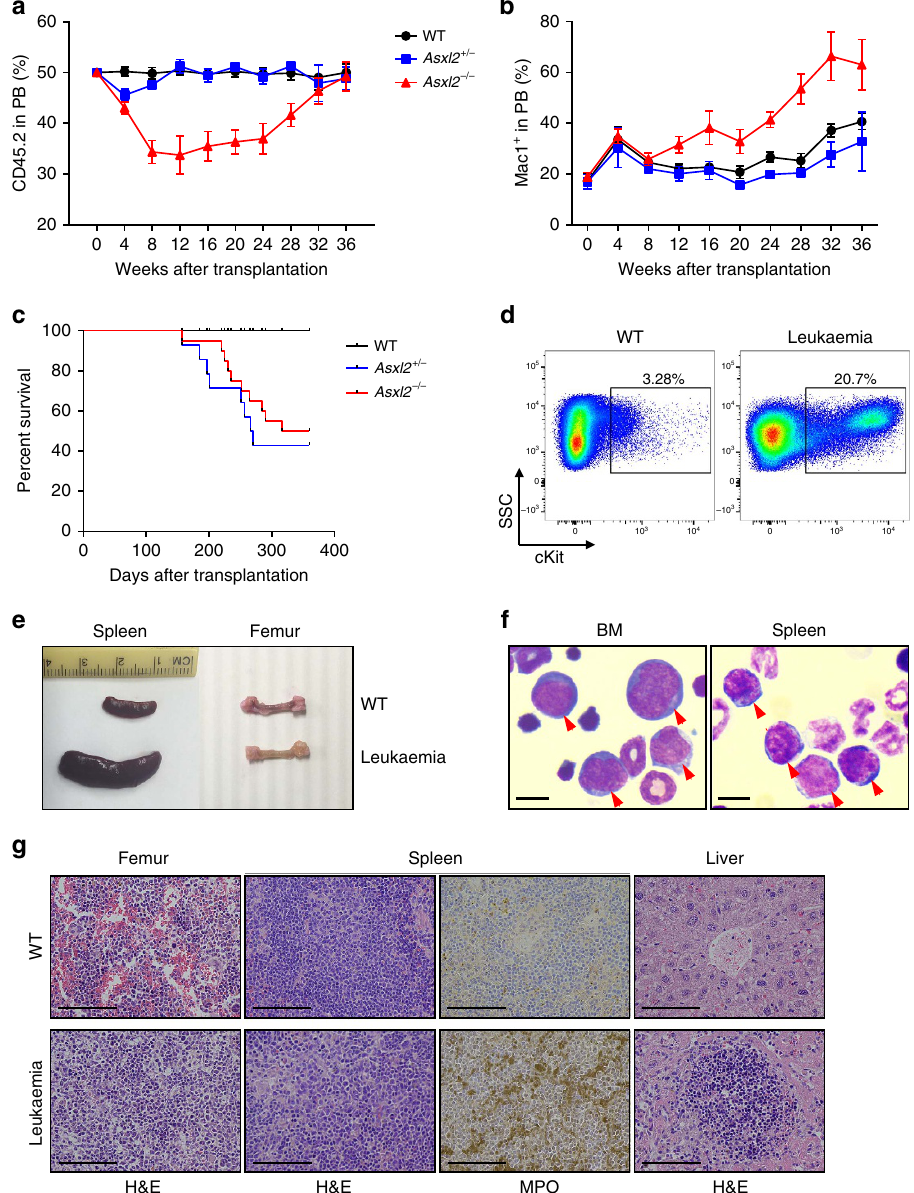
Figure 4 | Cell-autonomous effect of malignant progression in Asxl2 þ / (cid:2) and Asxl2 (cid:2) / (cid:2) mice. ( a ) The kinetics of CD45.2 chimerism in the PB of mice receiving WT, Asxl2 þ / (cid:2) or Asxl2 (cid:2) / (cid:2) BM cells (mean ± s.e.m., four to eight mice per genotype). ( b ) The kinetics of percent Mac1 þ cells in CD45.2 þ cells of mice receiving WT, Asxl2 þ / (cid:2) or Asxl2 (cid:2) / (cid:2) BM cells (mean ± s.e.m., four to eight mice per genotype). ( c ) Kaplan–Meier curve shows the per cent survival of mice received WT, Asxl2 þ / (cid:2) or Asxl2 (cid:2) / (cid:2) BM cells over time. ( d ) Flow cytometric analysis of cKit þ cells in BM. ( e ) Representative gross appearance of spleens and bones. ( f ) Representative images of May–Gru¨nwald–Giemsa-stained cytospin preparations of BM and spleen cells from representative leukemic mice receiving Asxl2 (cid:2) / (cid:2) BM cells. Red arrows indicate myeloblastic cells. Scale bar, 10 m m. ( g ) H&E-stained sections of the femurs, spleens and livers, and MPO-stained spleen sections from a representative leukemic recipient mouse transplanted with Asxl2 (cid:2) / (cid:2) BM cells and a recipient mouse receiving WT BM cells. Scale bar, 100 m